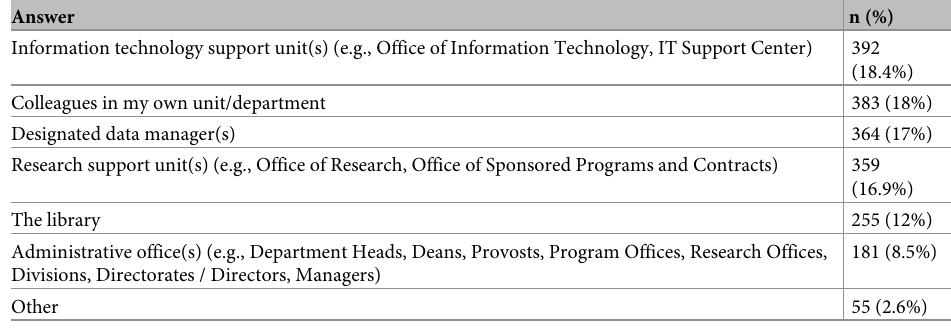
Table 11. “You have expressed agreement that your organization or project has a formal process for managing or storing data during or beyond the life of the project (short-term or long-term). Which of the following are involved with this process? (Choose all that apply)”.